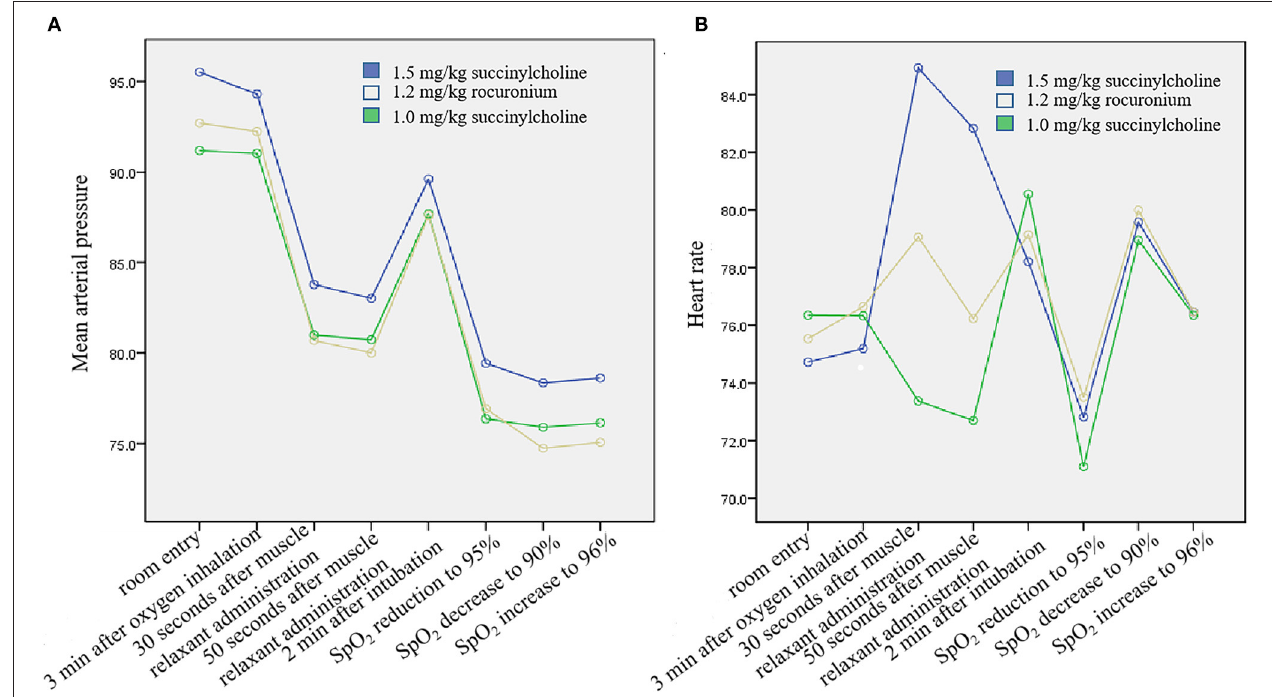
FIGURE 2 | Mean arterial pressure and heart rate variation. (A) Mean arterial pressure. Two-way repeated measurement ANOVA suggested that time and treatment interaction was comparable ( P = 0.279). (B) Heart rate. Two-way repeated measurement ANOVA suggested that time and treatment interaction showed statistical significance among the groups ( P < 0.001), though no clinical significance was